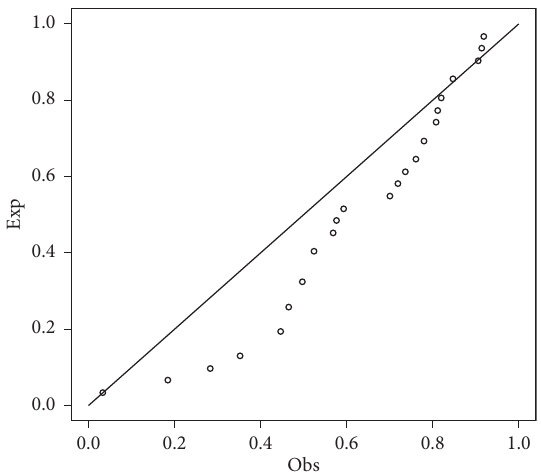
Figure 6: PP plots of the TIITFILi for the